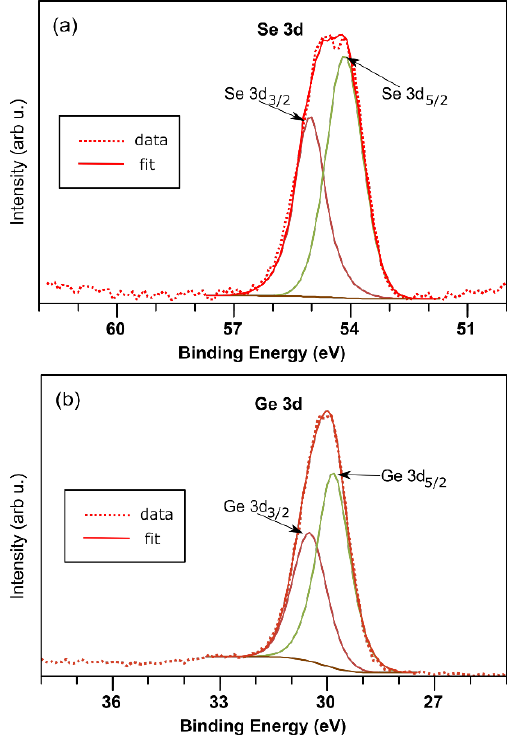
Figure 3. XPS spectra of ( a ) the Se 2p and ( b ) Ge 3d core levels for the GeSe sample. Positions of the components for Se 3d are 55.5 eV and 54.15 eV, for Ge 3d are 30.5 eV and 29.85 eV.